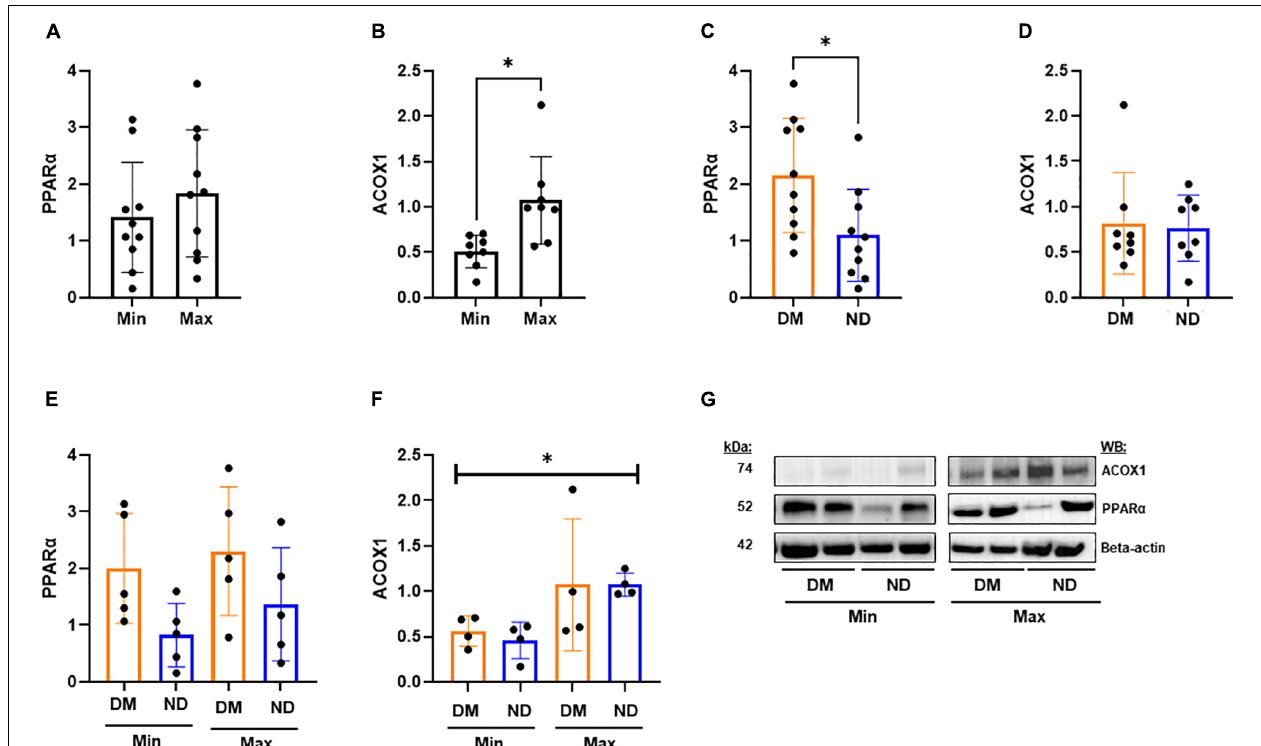
FIGURE 3 | Western blot analysis from CEA in varying disease and diabetic status. (A,B) We observed no significant difference in PPAR α protein expression between Min ( n = 10) and Max ( n = 10) segments, but a significant decrease in relative ACOX1 abundance in Min tissues compared to Max ( p < 0.05). (C) Patients with diabetes ( n = 10) demonstrate significantly higher relative PPAR α abundance compared to patients without diabetes ( p < 0.05). (D) No significant difference in ACOX1 expression among patients with an without diabetes. (E) No significant variability in PPAR α from combined analysis of diabetic status and lesion severity analysis. (F) Kruskal-Wallis test shows significant variability in relative ACOX1 abundance between Min and Max specimens from patients with ( n = 4) or without ( n = 5) diabetes. (G) Representative Western Blots from analysis. Samples were normalized to beta-actin content. DM, Diabetic. ND, Non-diabetic. Min, Minimally diseased. Max, Maximally diseased. Data are presented as Mean ± SD, and each point represents one patient sample. ∗ p <